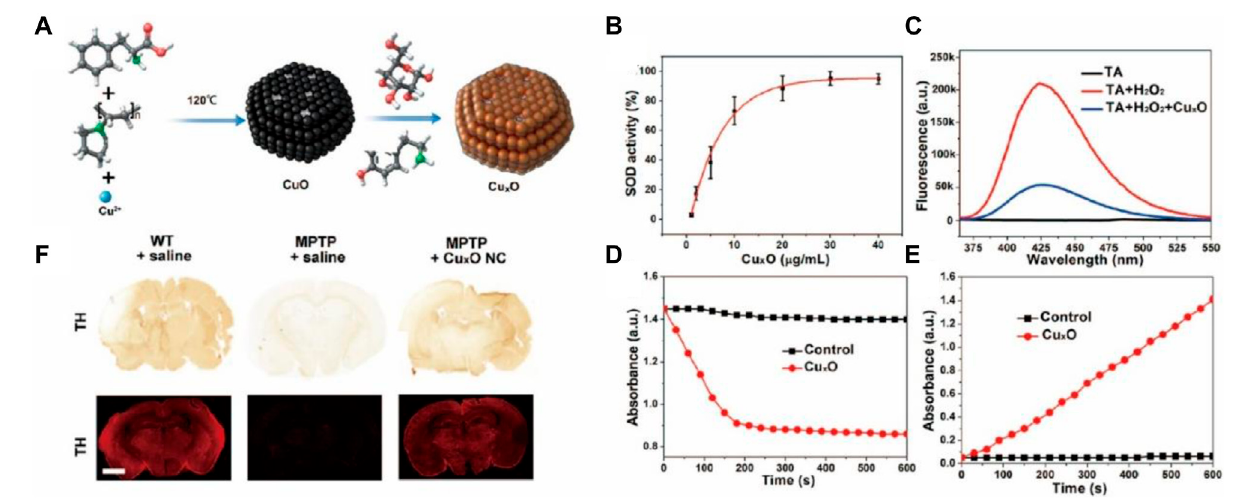
FIGURE 6 | (A) Schematic showing the preparation of CuxO. CuxO exhibits multienzyme-likeactivities. (B) SOD-like activity, (C) CAT-like activity, (D) GPx-like activity, (E) POD-like activity. (F) Immunohistochemistry (IHC) images and immunohisto fl uorescence (IHF) images of tyrosine hydroxylase (TH) in the brains of control, MPTP-induced PD mice, and CuxO NCs-treated mice. Scale bar: 1 mm. Reproduced from Singh et al. (2017) with permission from the American Chemical